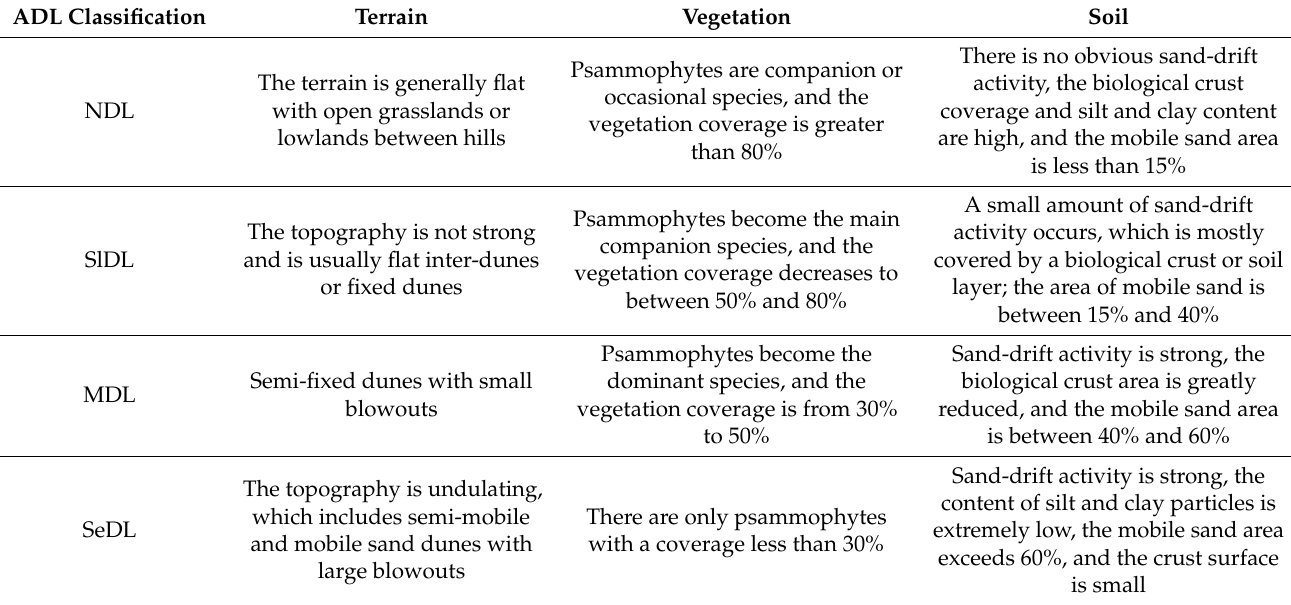
Table 1. Land classification system in the Zhenglan Banner.